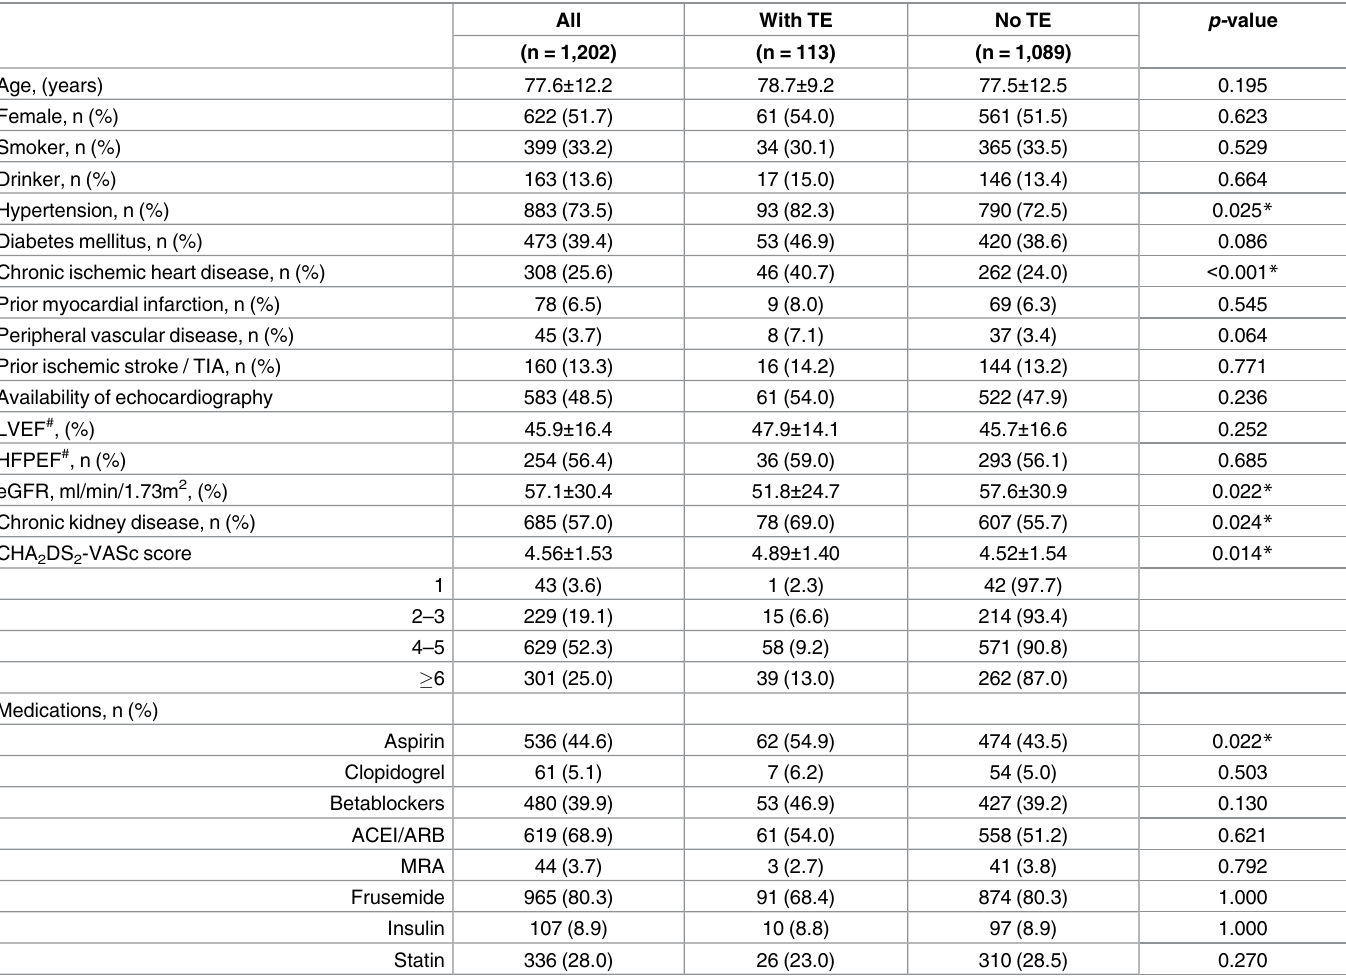
Table 1. Baseline characteristics of 1,202 heart failure patients in sinus rhythm with and without thromboembolic